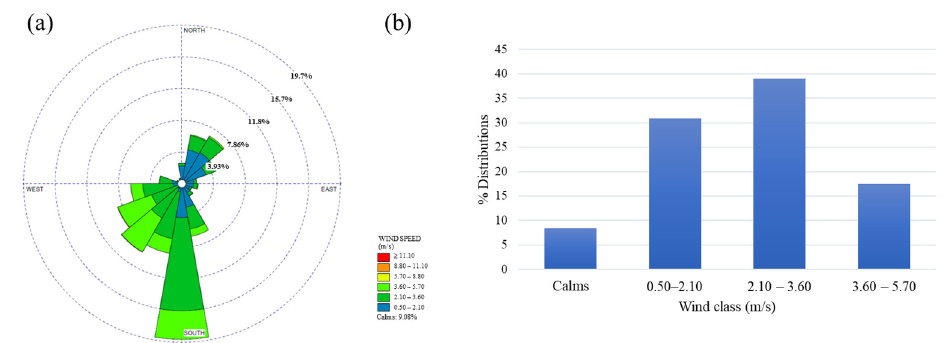
Figure 2. ( a ) Wind rose plot of study area; ( b ) % distribution of wind classes.